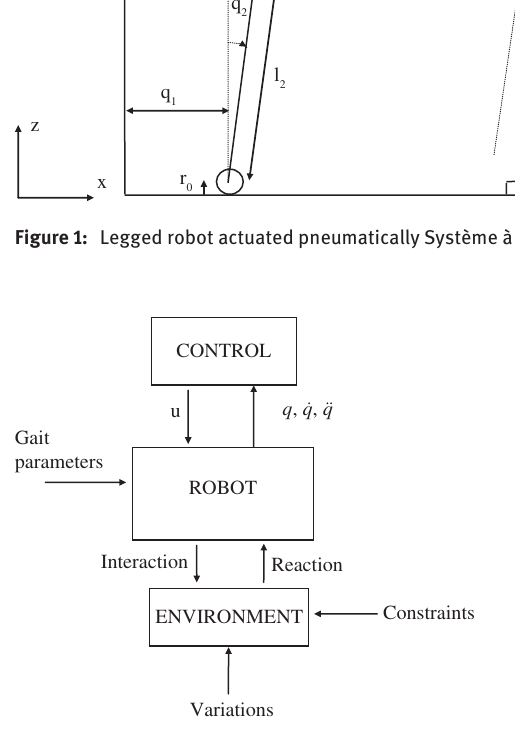
Figure 2: Control-robot-environment interactions.